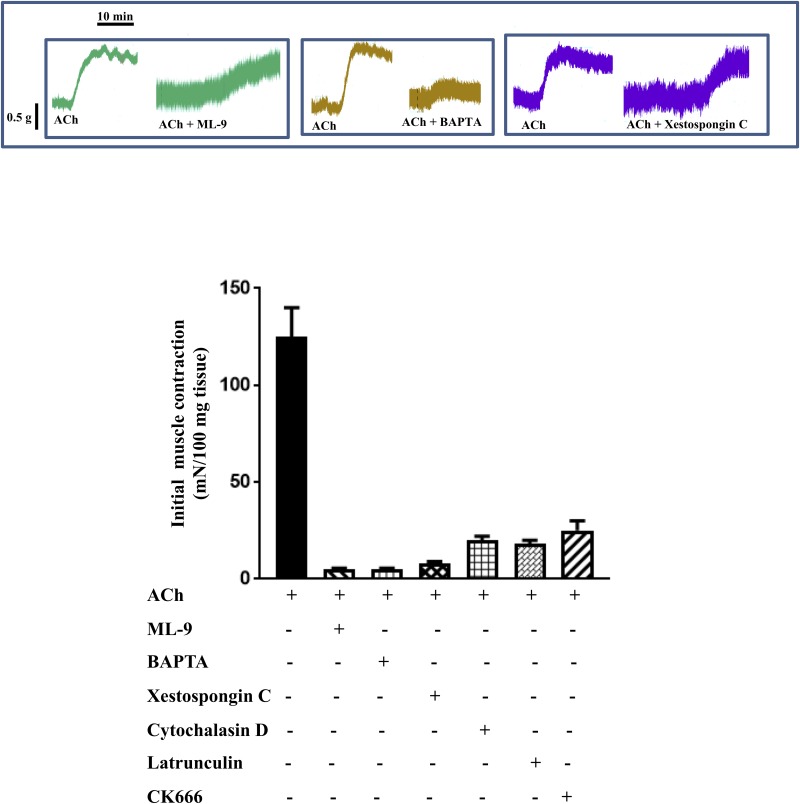
Inhibition of initial actin polymerization prevents ACh-induced initial smooth muscle contraction.Muscle contraction was measured as increase in initial contraction in response to acetylcholine (10 μM) in organ bath experiments in gastric smooth muscle of mice in the presence or absence of MLCK inhibitor ML-9 (10 μM, 10 min), Ca2+ Chelator BAPTA (10 μM, 15 min), IP3 receptor inhibitor Xestospongin C (10 μM, 15 min) or Arp2/3 inhibitor CK-666 (200 μM, 1h), actin polymerization inhibitors (cytochalasin D, 10 μM; latrunculin, 1 μM, 1 h). Results are expressed as mN/100 mg of tissue. Values are means ±SE of 4–6 experiments. **P<0.001.